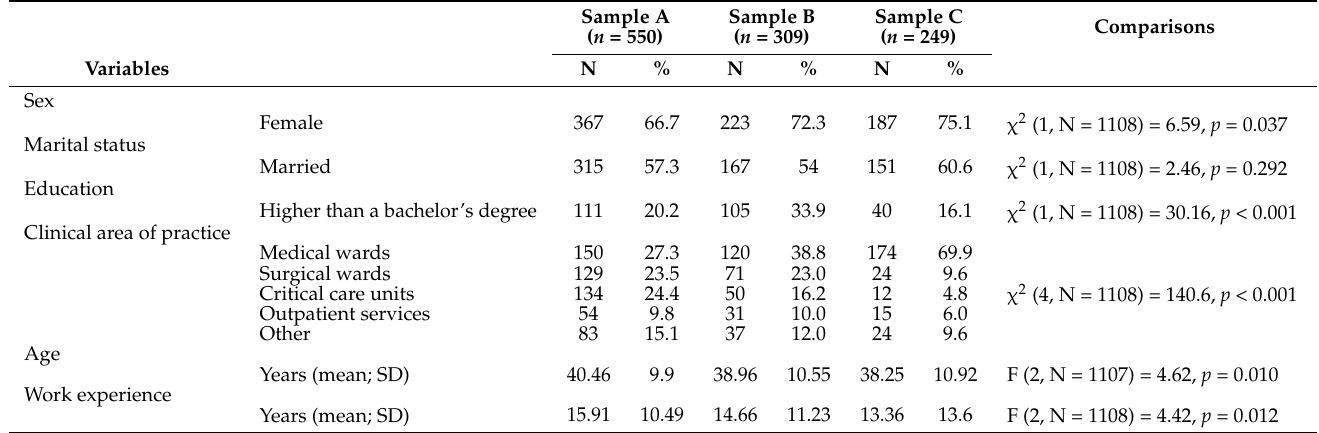
Table 1. Characteristics of the respondents in the three samples (N overall =